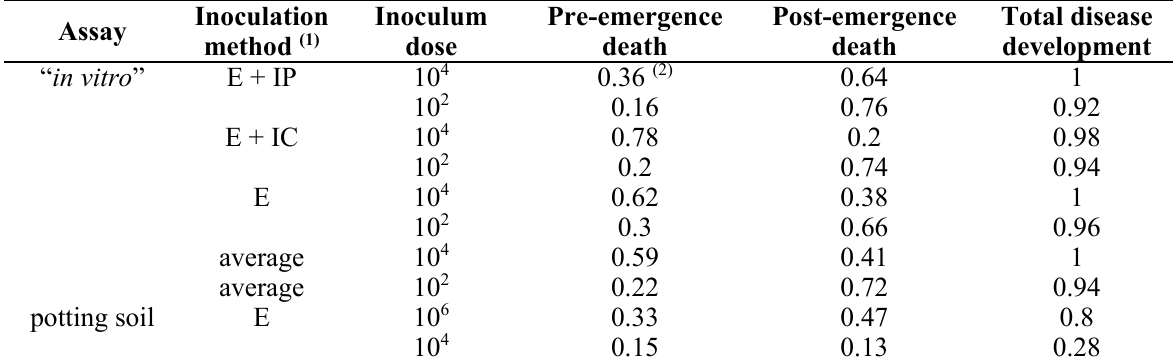
Table 3. Transmission rate of F. circinatum from inoculated seeds to germinating seeds and symptomatic seedlings at 48 days after inoculation as determined in vitro and in potting soil